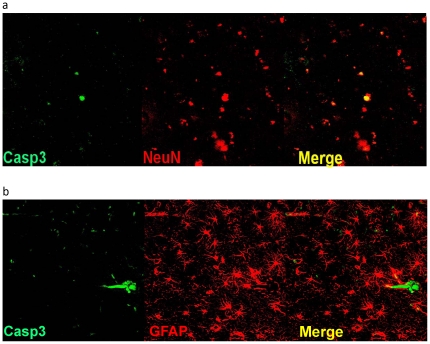
Double labeling with caspase 3 and neuronal or glial markers.
a) Double labeling of activated caspase 3 with the neuronal marker NeuN and b) the glial marker GFAP revealed that the majority of cells positive for activated caspase-3 were also NeuN positive.